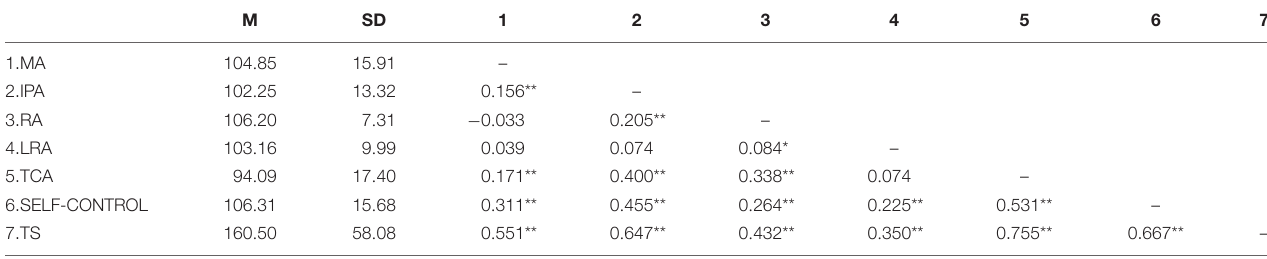
TABLE 1 | Means, standard deviations, and intercorrelations for variables.